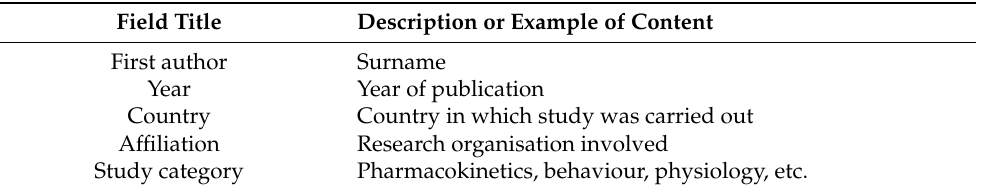
Table 3. Information Collated into Stocktake